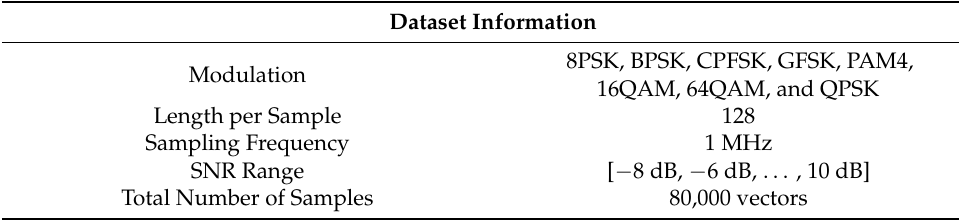
Figure 2. Radio signal dataset: ( a ) original clean signal waveform; ( b ) noisy signal waveform. Table 2. Dataset